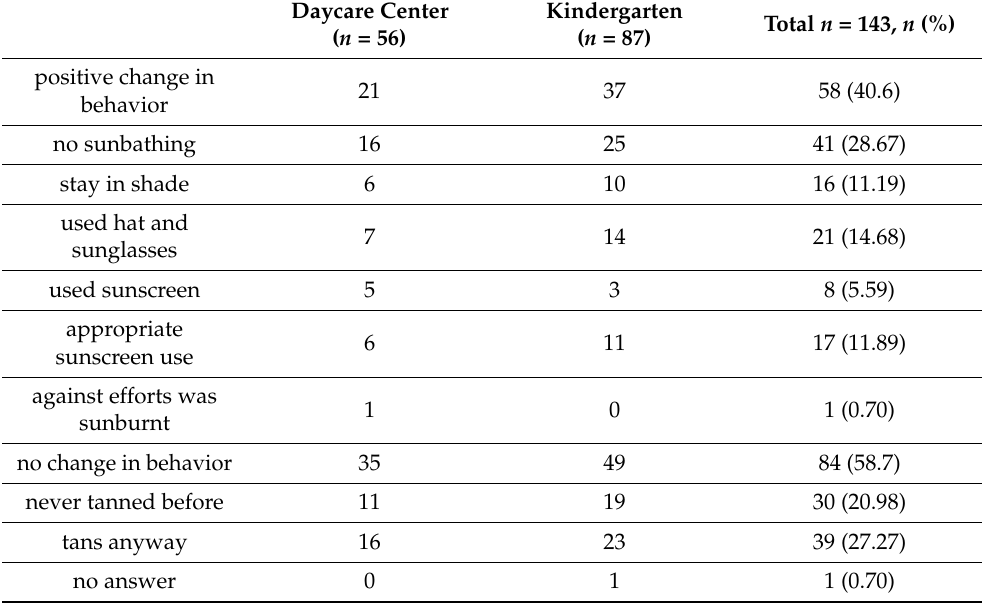
Table 3. Changes in sun-protection habits among caregivers in child